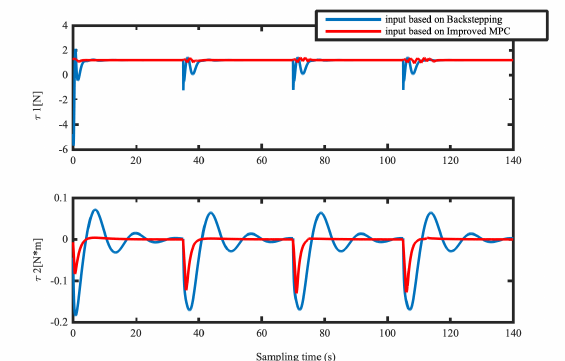
Figure 17. The comparison of the control input with the backstepping method in square tracking.